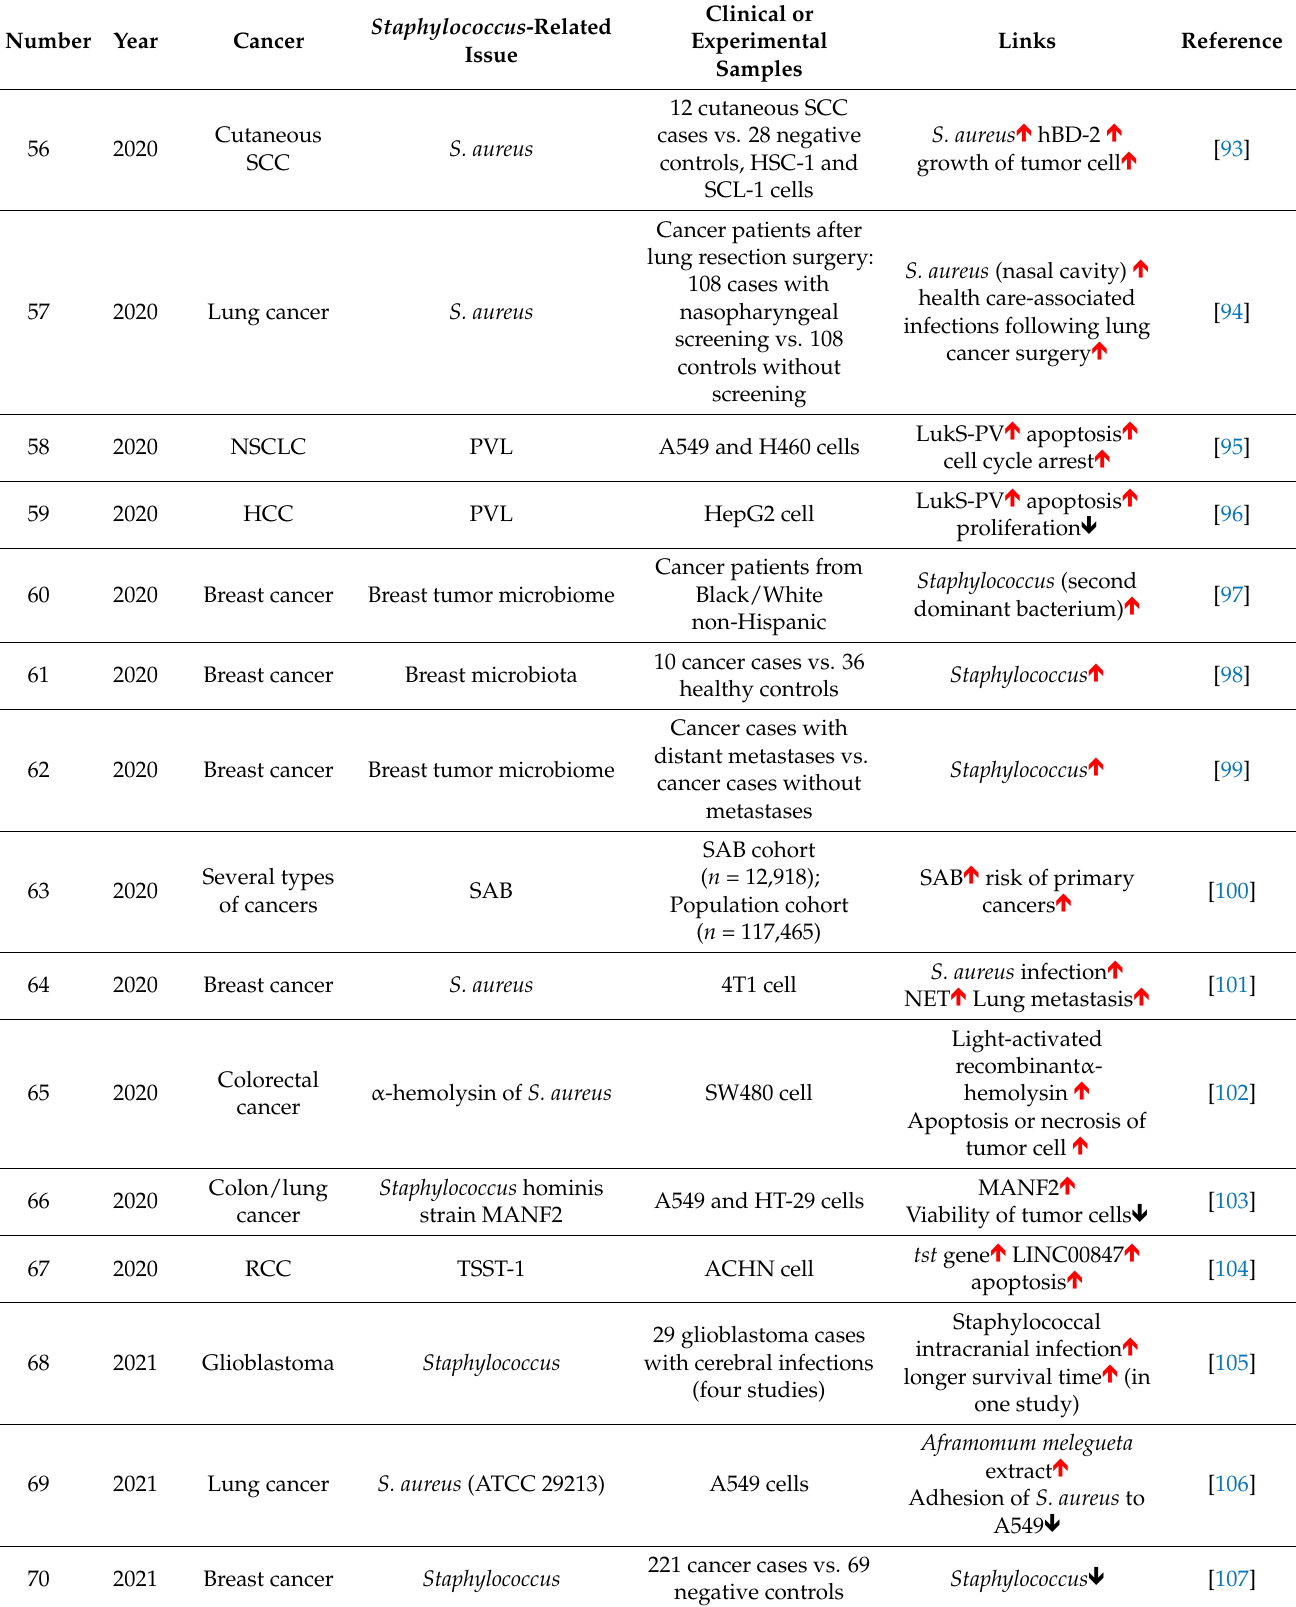
Table 1. Cont. Table 1. Summary of evidence on Staphylococcus and carcinogenesis. Table 1. Summary of evidence on Staphylococcus and carcinogenesis. Table 1. Summary of evidence on Staphylococcus and carcinogenesis.